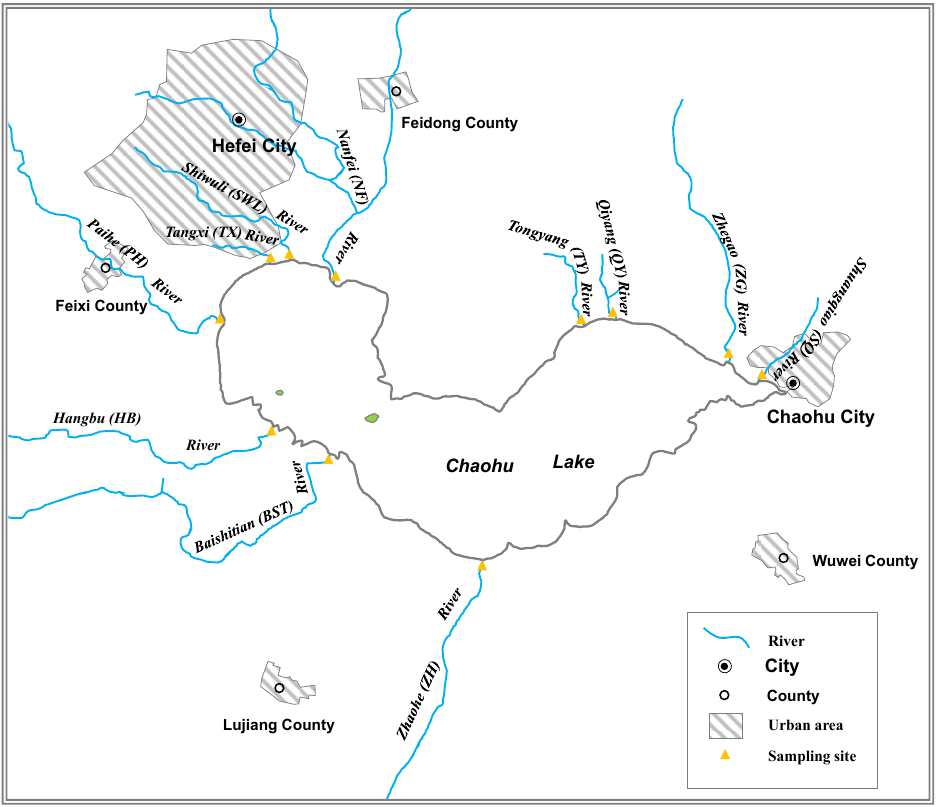
Figure 1. Sketch of the sampling sites and 11 rivers flowing into Lake